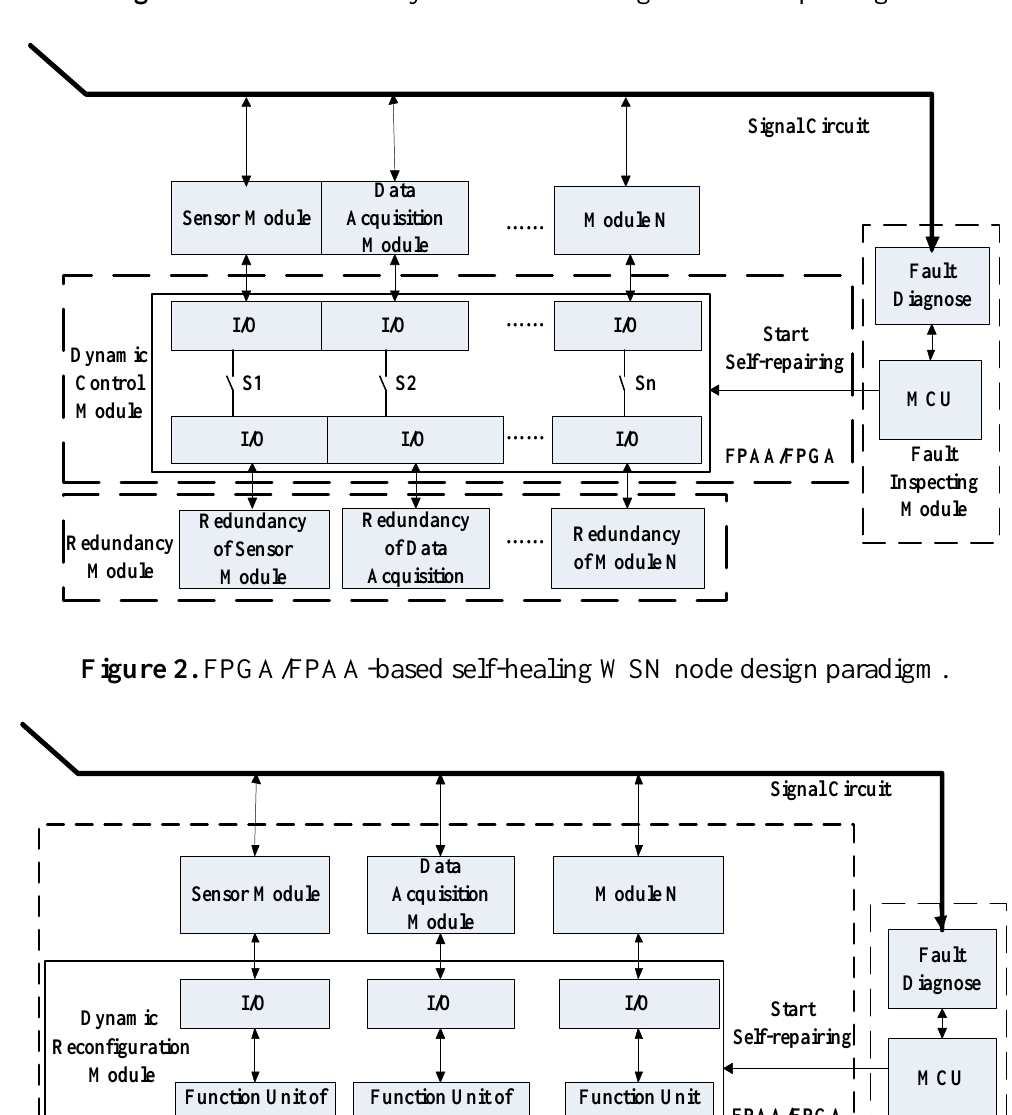
Figure 1. The redundancy-based self-healing WSN node paradigm.